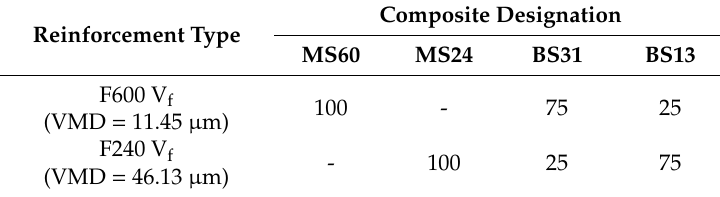
Table 1. Content of the silicon carbide (SiC) reinforcement and the designation of the composites: V f is the particle volume fraction, and VMD is the reinforcement volume mean diameter; F240 and F600 refer to the commercial grades of SiC powders; MS and BS mean monomodal SiC and bimodal SiC,